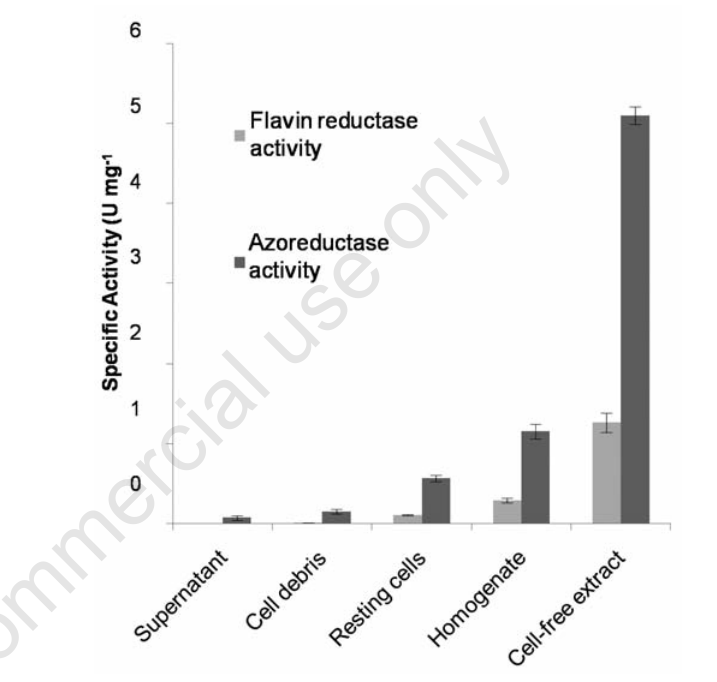
Figure 2. The azo reductase and flavin reductase activities of different cell fractions of C. freundii A1.